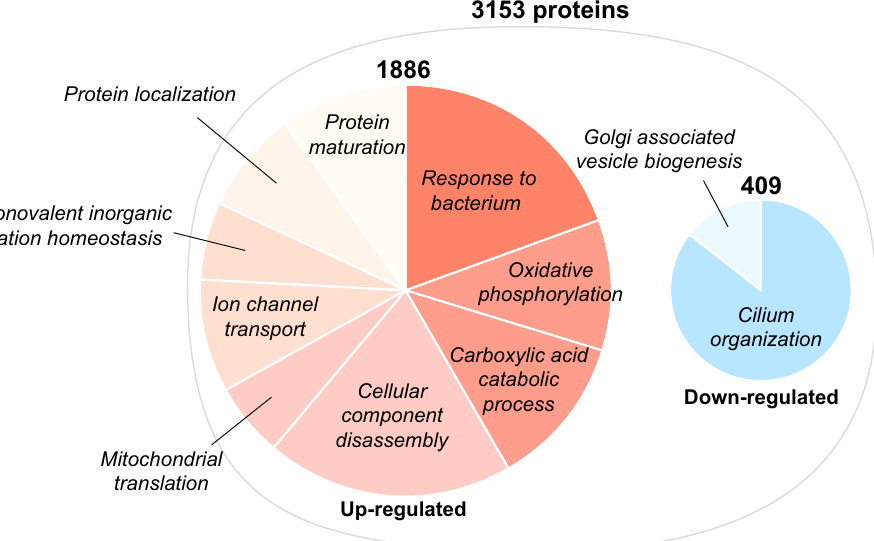
Figure 2. Altered biological pathways in left atrial tissue of AF patient. The result of GSEA is summarized. The right and left pie chart show the up-regulated and down-regulated gene-sets in AF (FDR-adjusted p -value < 0.1), respectively. The gene-sets that hierarchically belong to the same/close branch, or share > 40% of the genes are colored